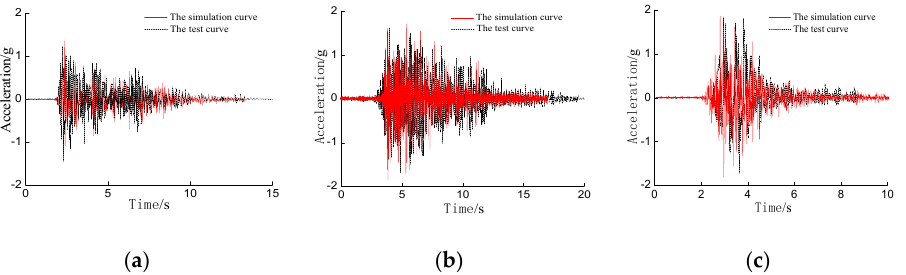
Figure 14. Comparison diagram of the acceleration simulation and test on top of a controlled tower under an 8-degree large earthquake. ( a ) El-Centro record. ( b ) Jiangyou record. ( c ) Artificial wave.